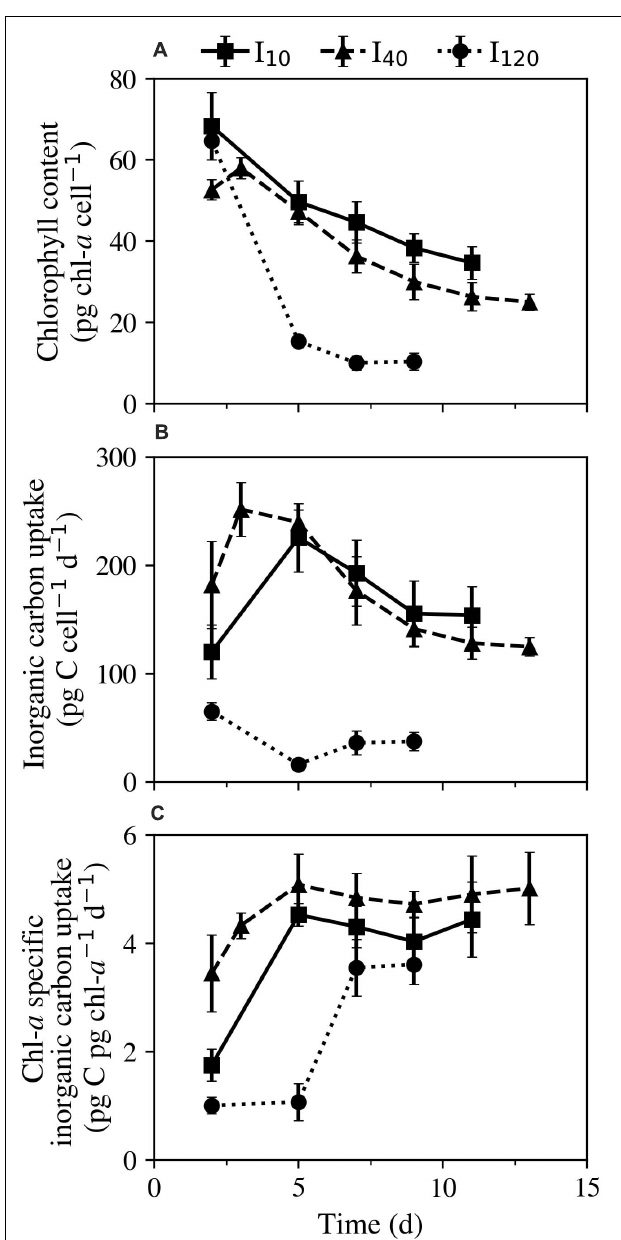
FIGURE 3 | Experiment 1: Physiological responses of Strombidium cf. basimorphum to starvation at three different light treatments (I 10 , I 40 , and I 120 ) as a function of time (d). (A) Cellular chl- a content. (B) Cellular photosynthetic rate. (C) Chl- a specific photosynthetic rate. Solid, dashed, and dotted lines denote light treatments I 10 , I 40 , and I 120 , respectively. Data points are means ± STD (n = 3).